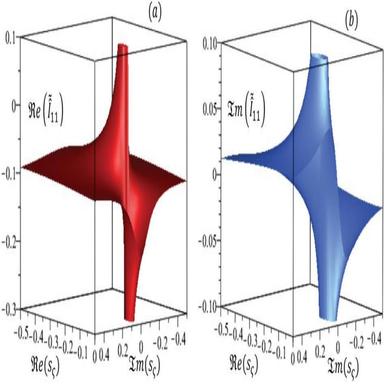
(a) Dimensionless real part component Re(˜ˆI11 ) vs. Re(s) and Im(sς ). (b) Dimensionless component Im(˜ˆI11 ) vs. Re(sς ) and Im(sς ), obtained for rρ = 10, rE = 10, τ i ς = 10, i = 1, 2, ν˜1 = ν˜2 = 0.2, η = 1 and γ = 1.